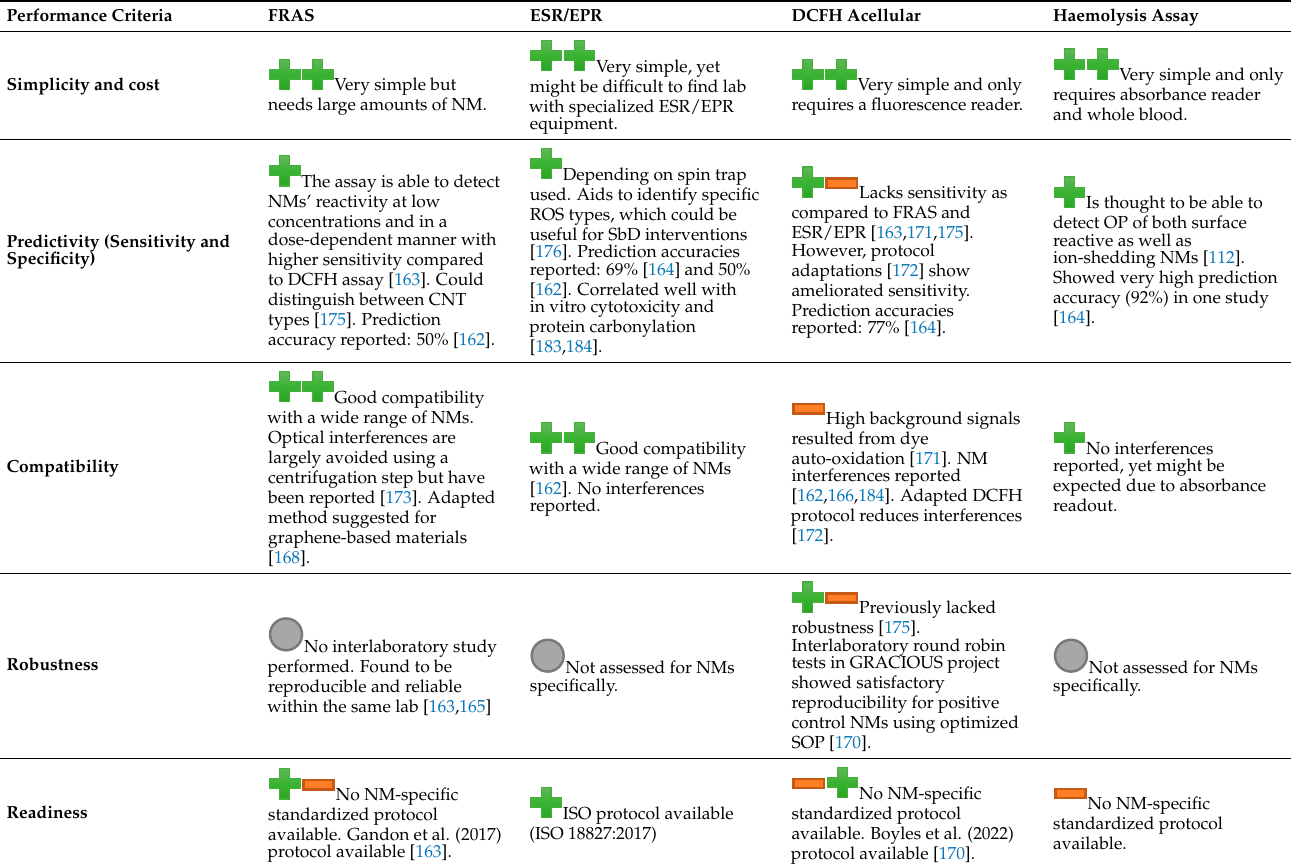
Table 1. Evaluation of suitability of cytotoxicity assays for SbD hazard testing.